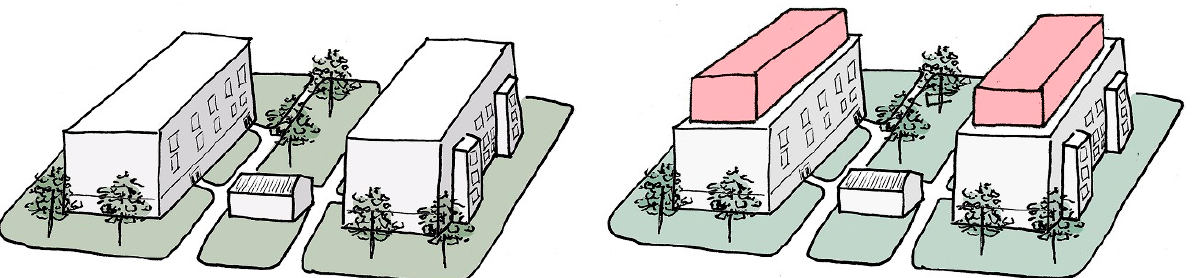
Figure 2. Additional floor construction.